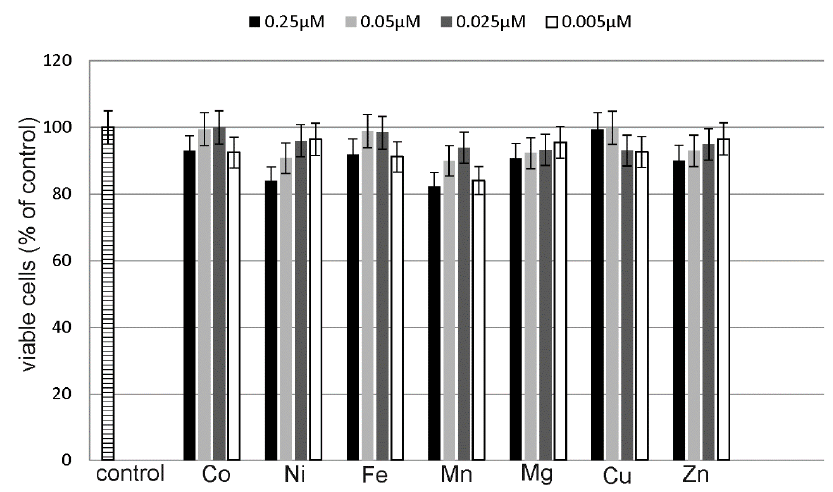
Figure 7. Co, Ni, Fe, Mn, Mg, Cu and Zn cytotoxicity in MCF-7 cells. The cells were incubated with 0.25 µM, 0.05 µM, 0.025 µM and 0.0005 µM of metal chlorides for 24 h. Mean values from